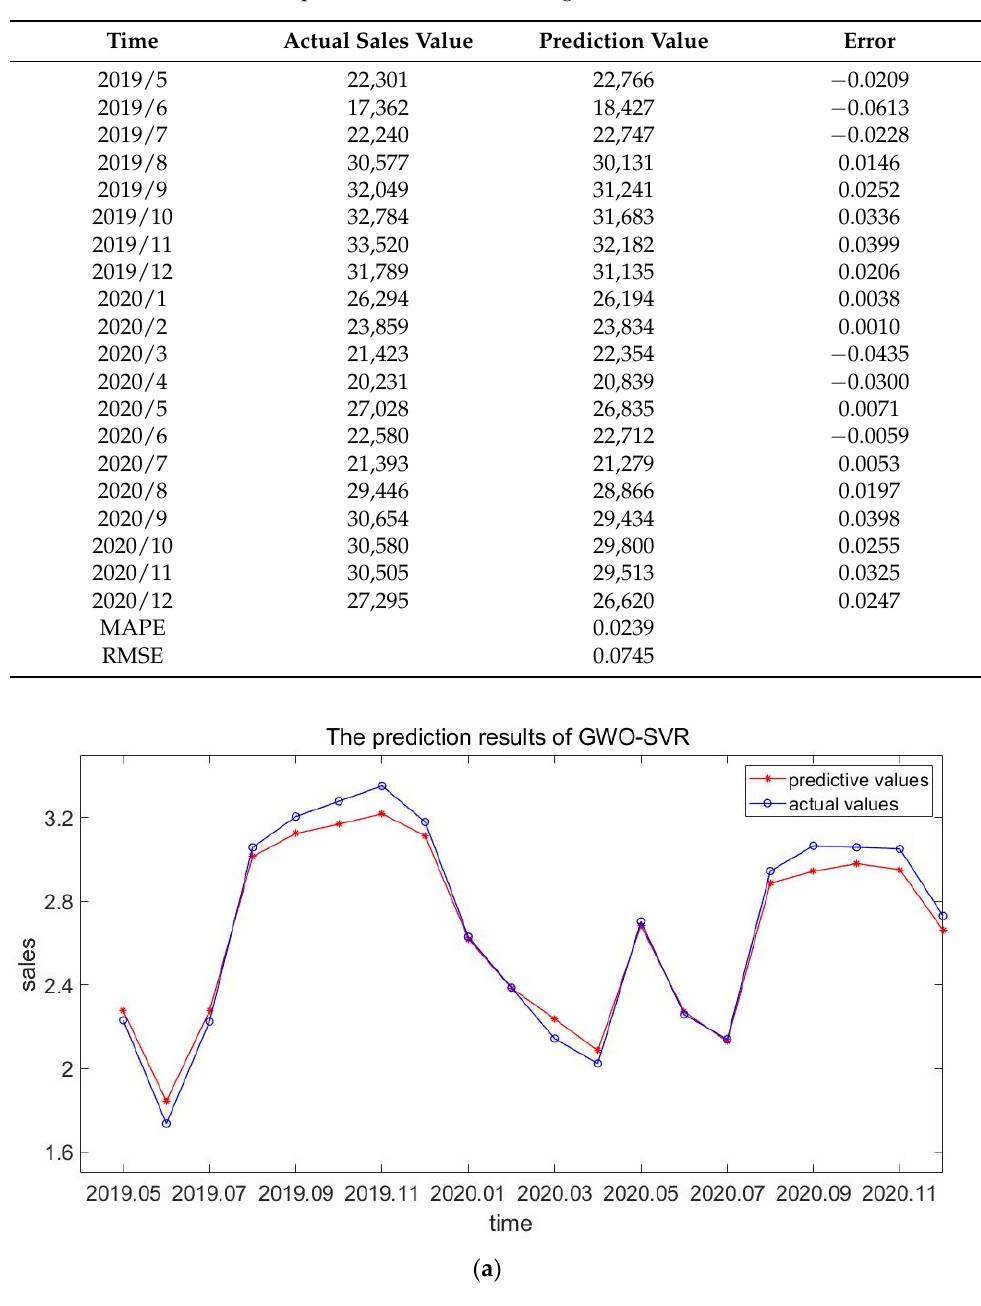
Table 3. The model fitted the prediction results of Suteng.